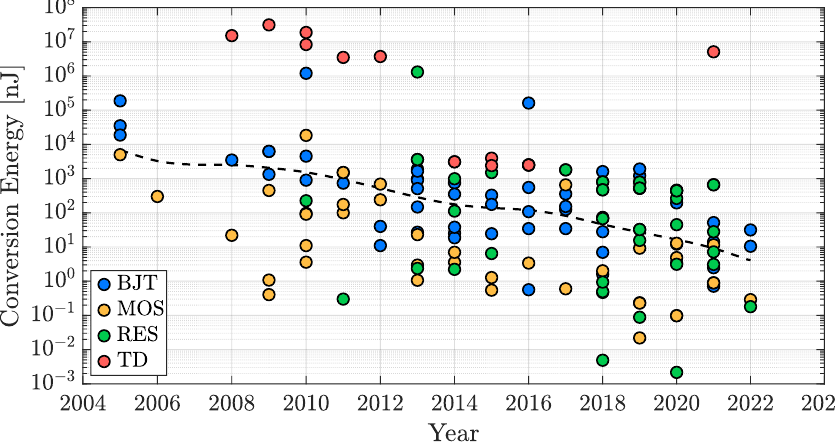
Figure 16. TDC conversion energy time evolution in the last two